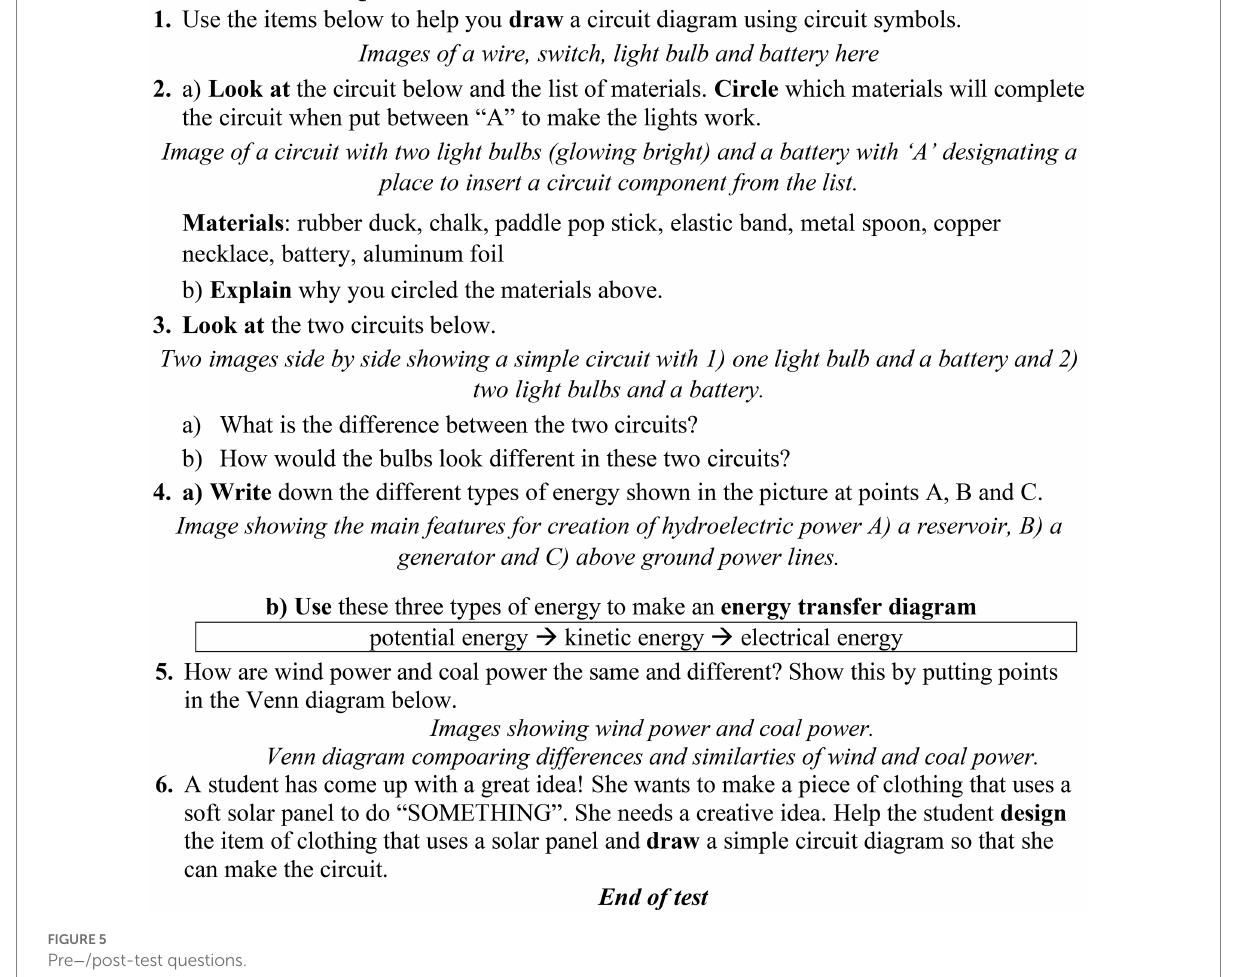
FIGURE 5 Pre − /post-test questions.